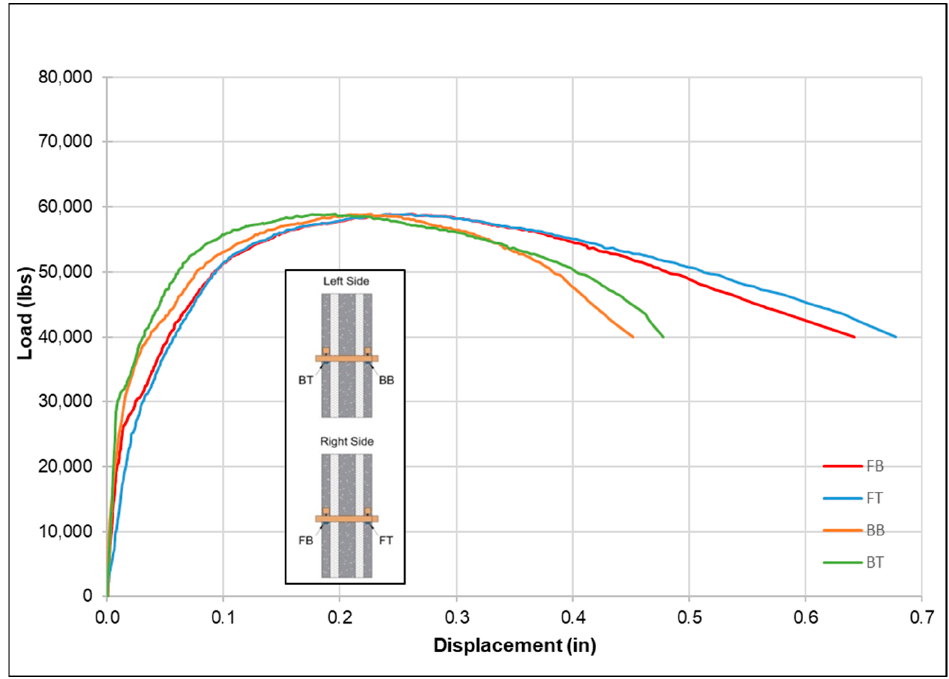
Figure 13. Load vs. displacement data from the four sensors for EPS.24.4.MMGRID.2.